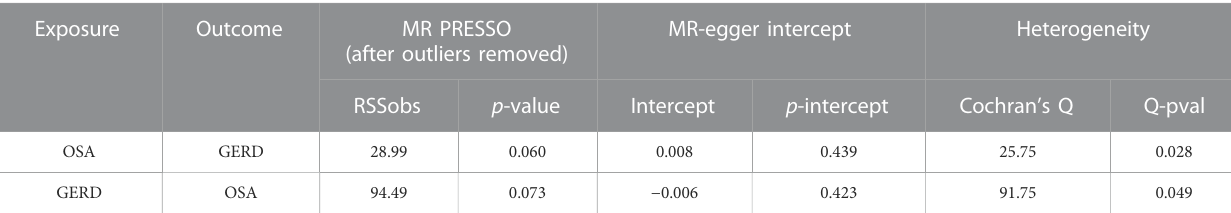
TABLE 1 Heterogeneity and horizontal pleiotropy analyses between OSA and GERD.